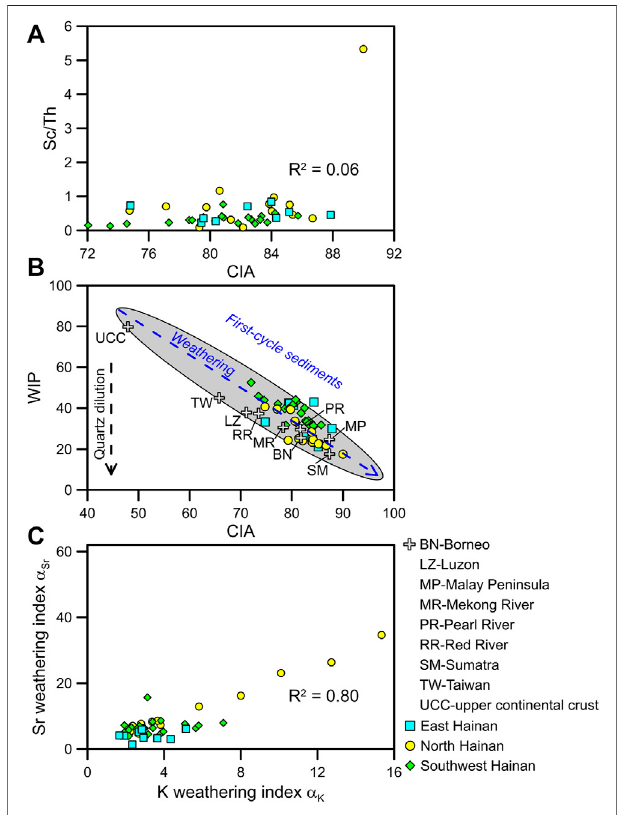
FIGURE3| Relationshipsbetween (A) CIA and Sc/Th, (B) CIA and WIP, and (C) α K and α Sr inriverinesedimentsoftheHainanIsland.TheCIAandWIP valuesoftheUCC(RudnickandGao,2003),Taiwanrivers(SelvarajandChen, 2006), Pearl, Red, and Mekong (Liu et al., 2007), Malay Peninsula, Sumatra, Borneo (Liu et al., 2012), and Luzon rivers (Liu et al., 2009) are also shown for comparison.